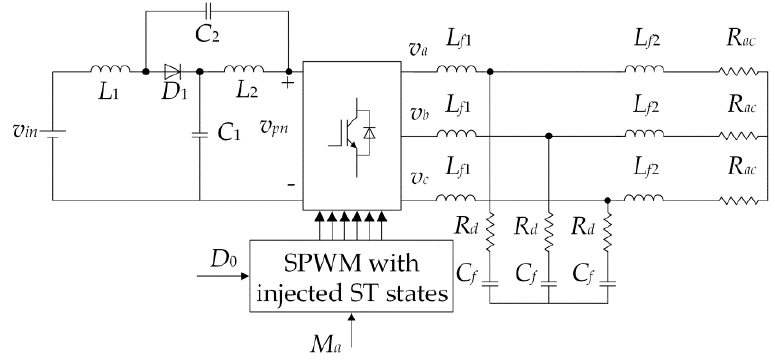
Figure 1. qZSI in a stand-alone configuration.